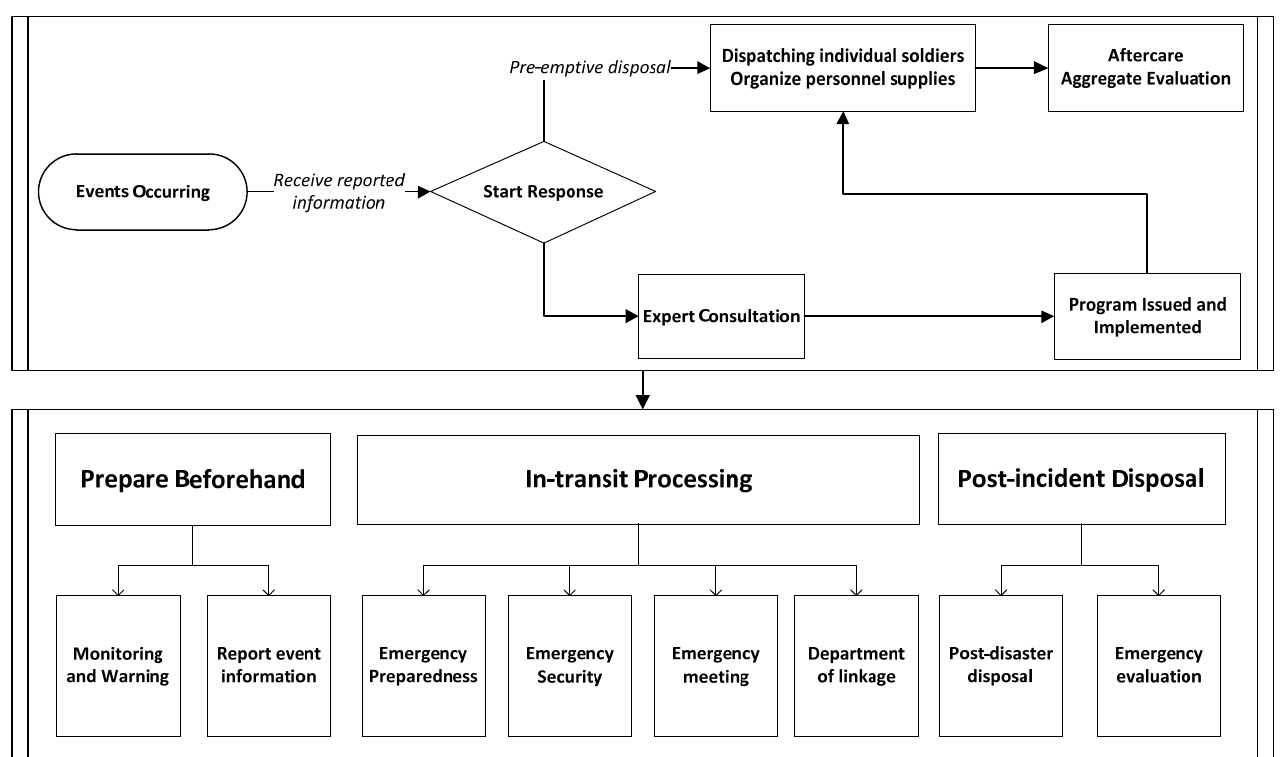
Figure 1. The framework of the actual case base.